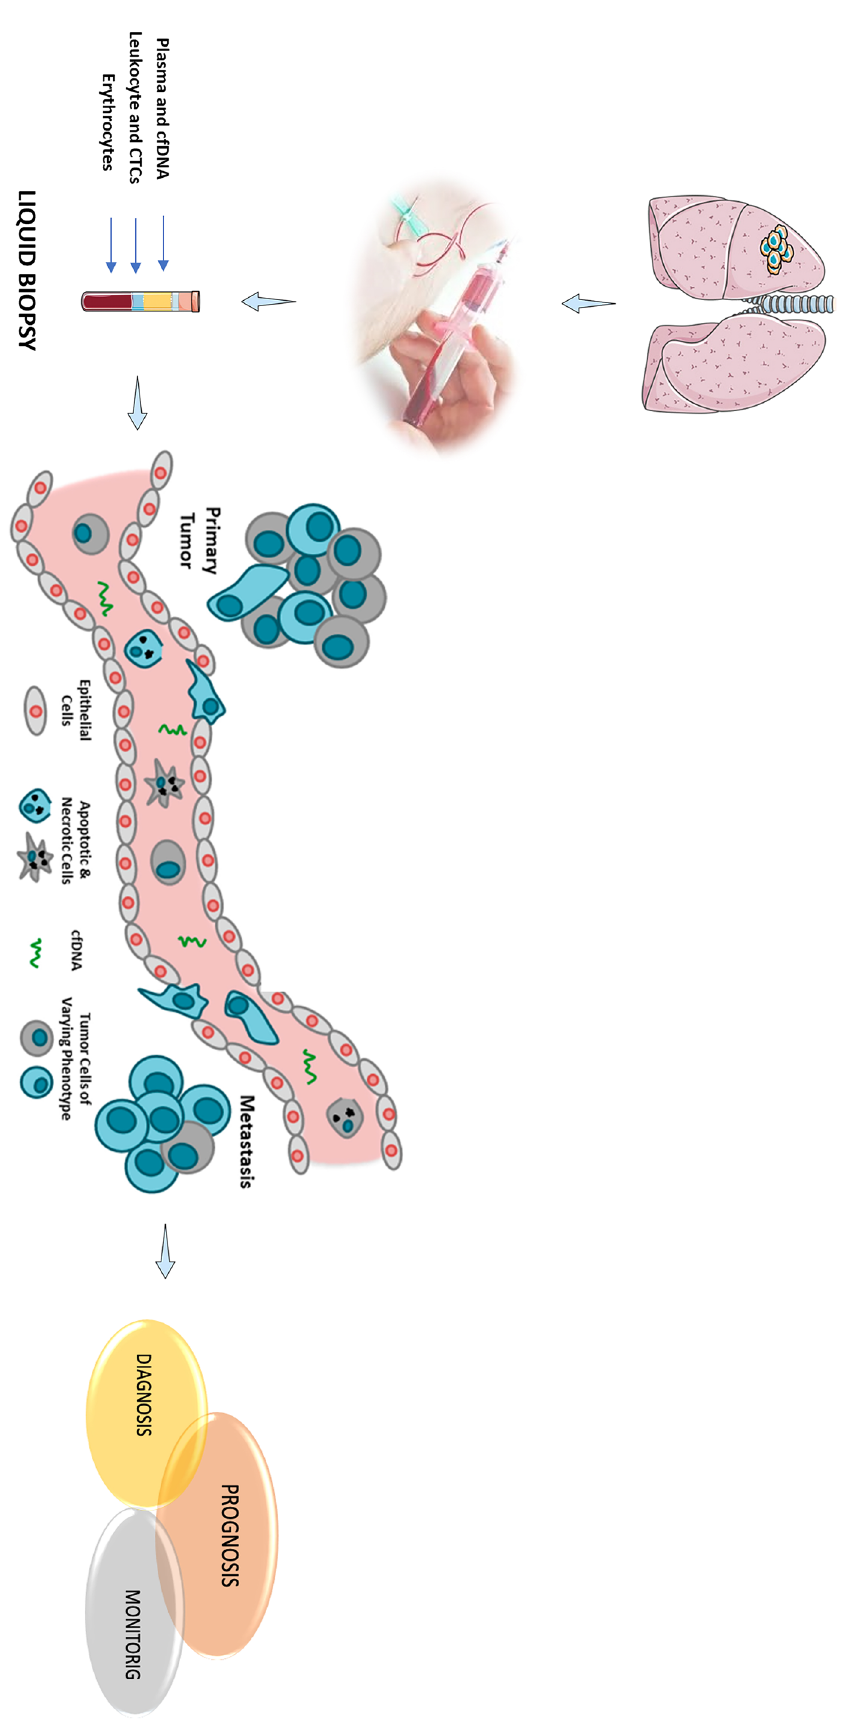
Figure 1. Overview of molecular liquid biopsy components. cfDNA: cell-free